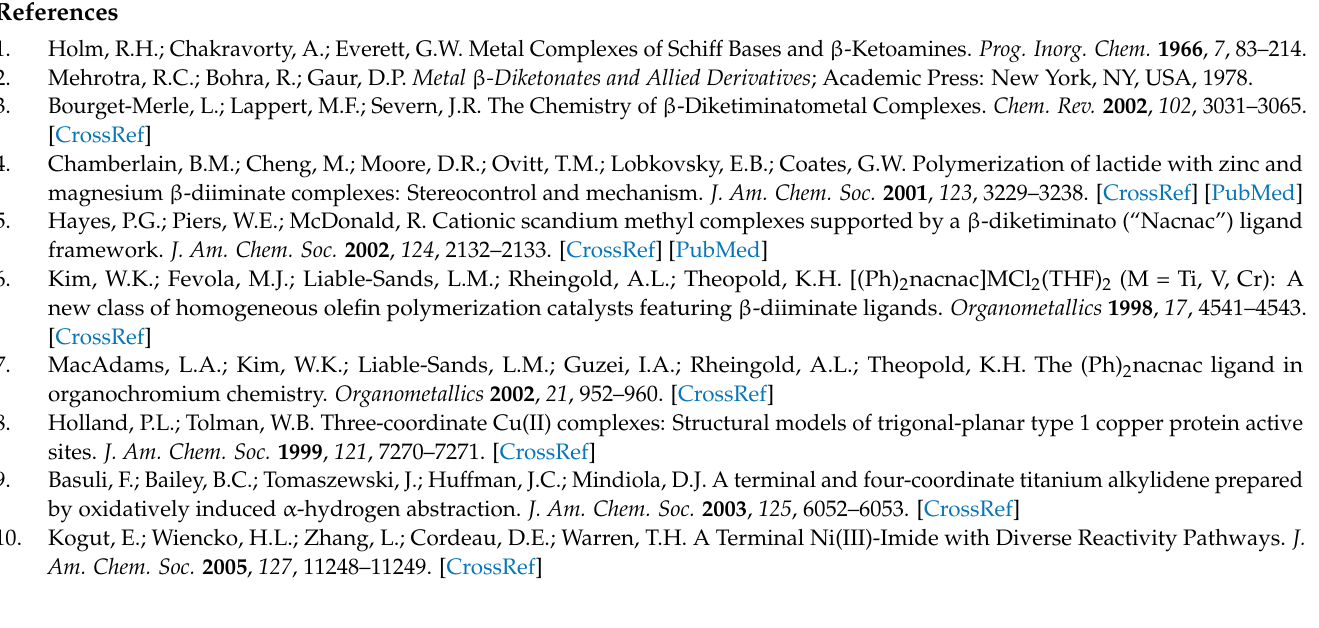
Figure S2: X-ray powder diffraction profiles of PE samples; Figure S3: FTIR of poly(norbornene); Figure S4: FTIR of poly(diciclopentadiene) and poly(5-ethylidene-2-norbornene); Figure S5: 1 H and 13 C NMR of poly(diciclopentadiene); Figure S6: 1 H and 13 C NMR of poly(5-ethylidene-2-norbornene); Figure S7: TGA curves of the poly(norbornene); Figure S8: FTIR of poly(norbornadiene); Figure S9: TGA curves of poly(diciclopentadiene) and poly(norbornadiene) samples; Figure S10: